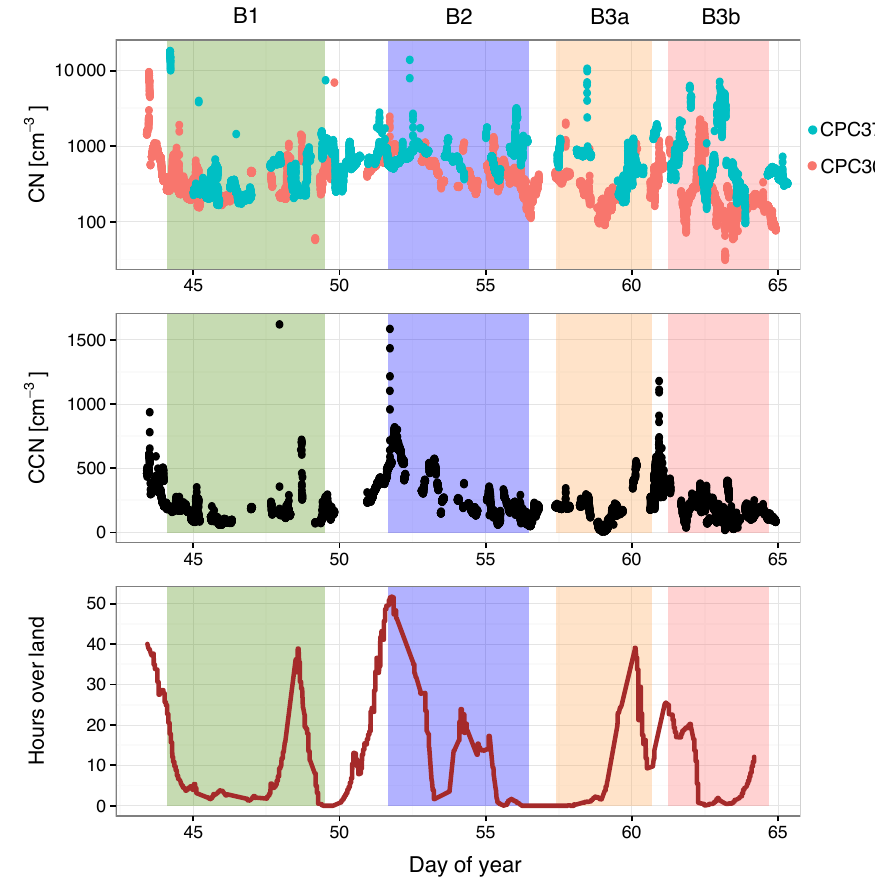
Figure 10. (a) Marine boundary layer CN concentrations (cm − 3 ; top; CPC3772 in blue, CPC3010 in red), (b) CCN concentrations (middle; cm − 3 ) and (c) number of hours over land indicated by 72h back trajectory (bottom; 27-member ensemble average). Bloom occupation periods are indicated by the vertical shaded bars and bloom labels at the top of the